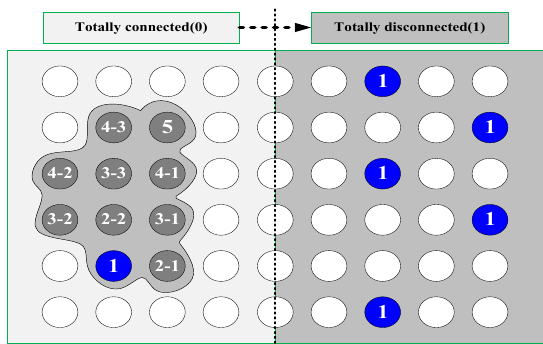
Figure 3. Two extreme two cases of steps (IV),